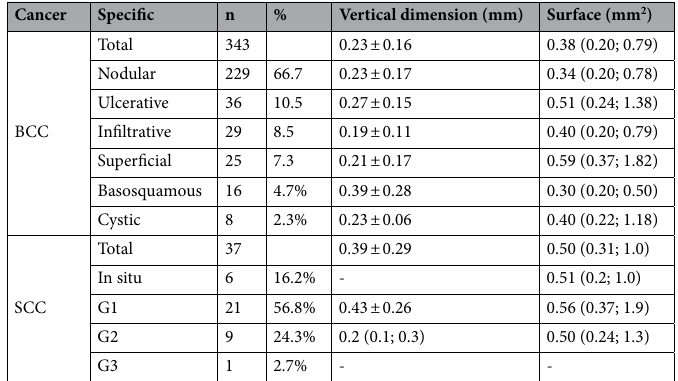
Table 3. Size parameters of keratinocyte carcinoma, data presented as average or median. BCC basal cell carcinoma, SCC squamous cell carcinoma.